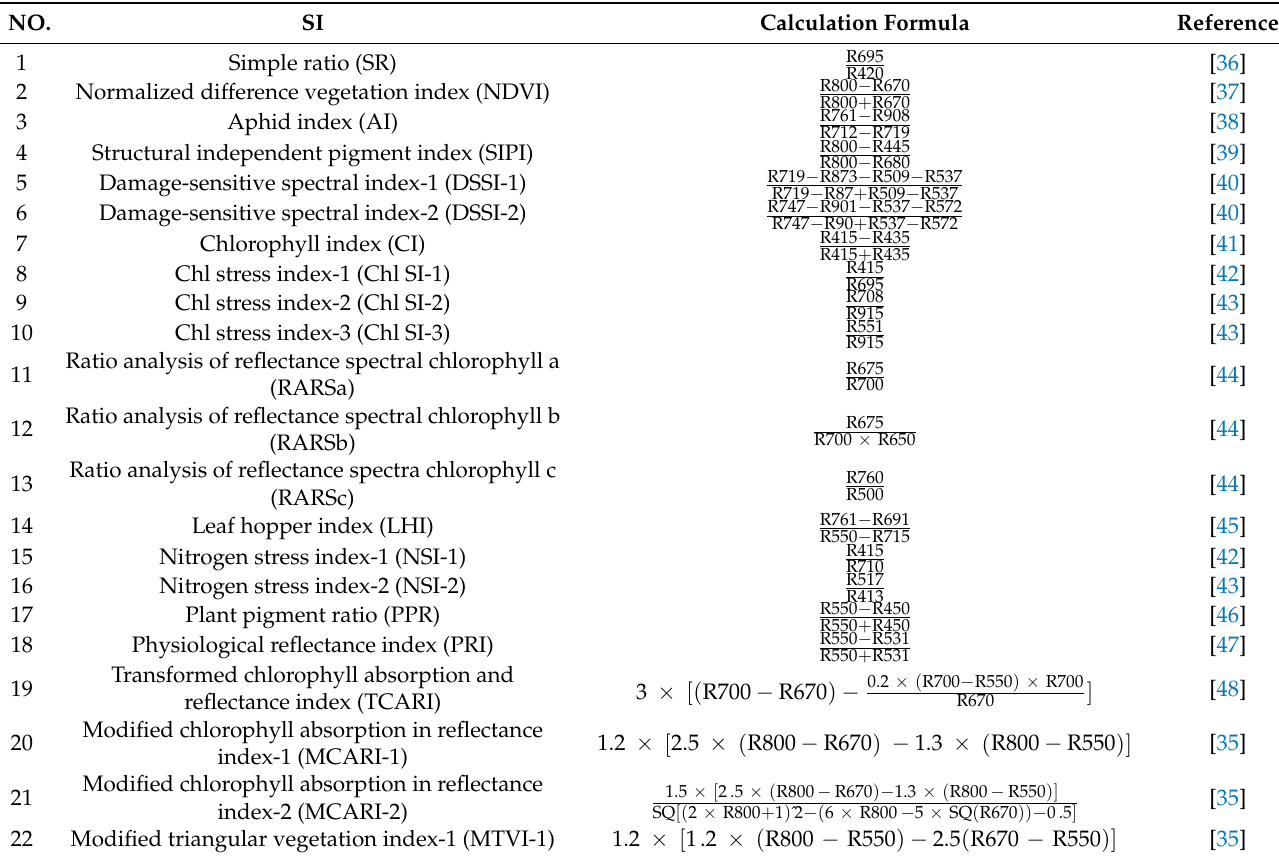
Table 4. SIs used in this